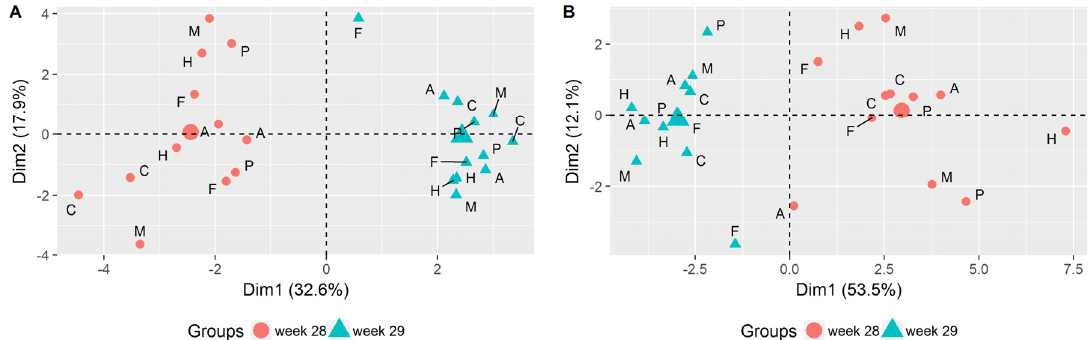
Figure 2. Principal component analysis (PCA) of the original, plot-adjusted dataset including both cucumber harvest sets from week 28 (red circles) and week 29 (green triangles). Score plots represent the individual samples of each picking set (separated by color) and plot (marked by the letters A, C, F, H, M, and P) based on dry matter-related data ( A ) and fresh matter-related data ( B ). The enlarged symbols (circle, triangle) represent group mean data points.